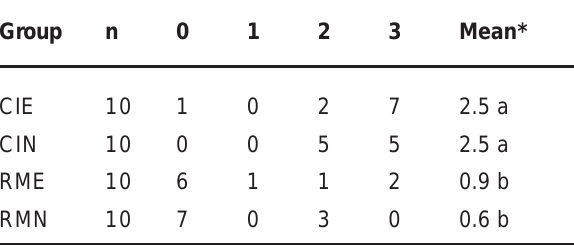
TABLE 2- Sample size, dye penetration scores, dye